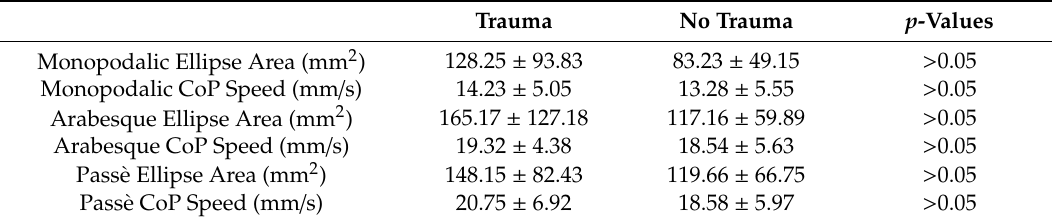
Table 3. Comparisons between injured and healthy feet in pathological subjects (N = 11) for stabilometric parameters acquired with open